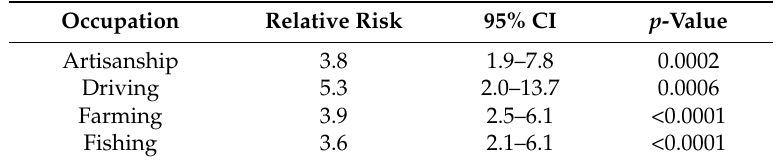
Table 4. Relative risk of the four main occupations with highest infection prevalence compared to all other occupations.